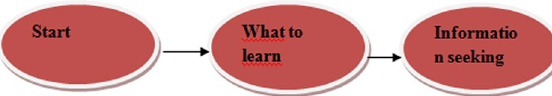
Fig. 9 Optimal path of personalization